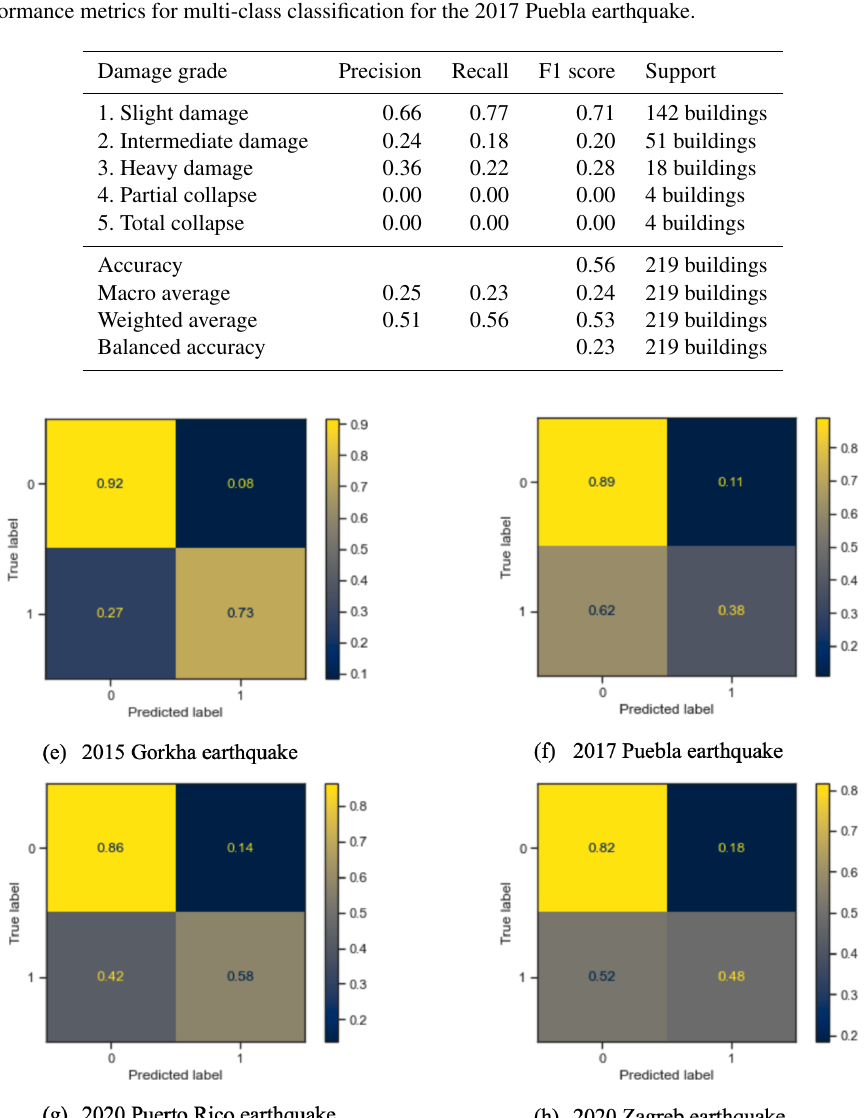
Figure 7. Normalized confusion matrices for the test set for binary damage classification. Label 0 refers to undamaged buildings, and label 1 refers to damaged buildings.